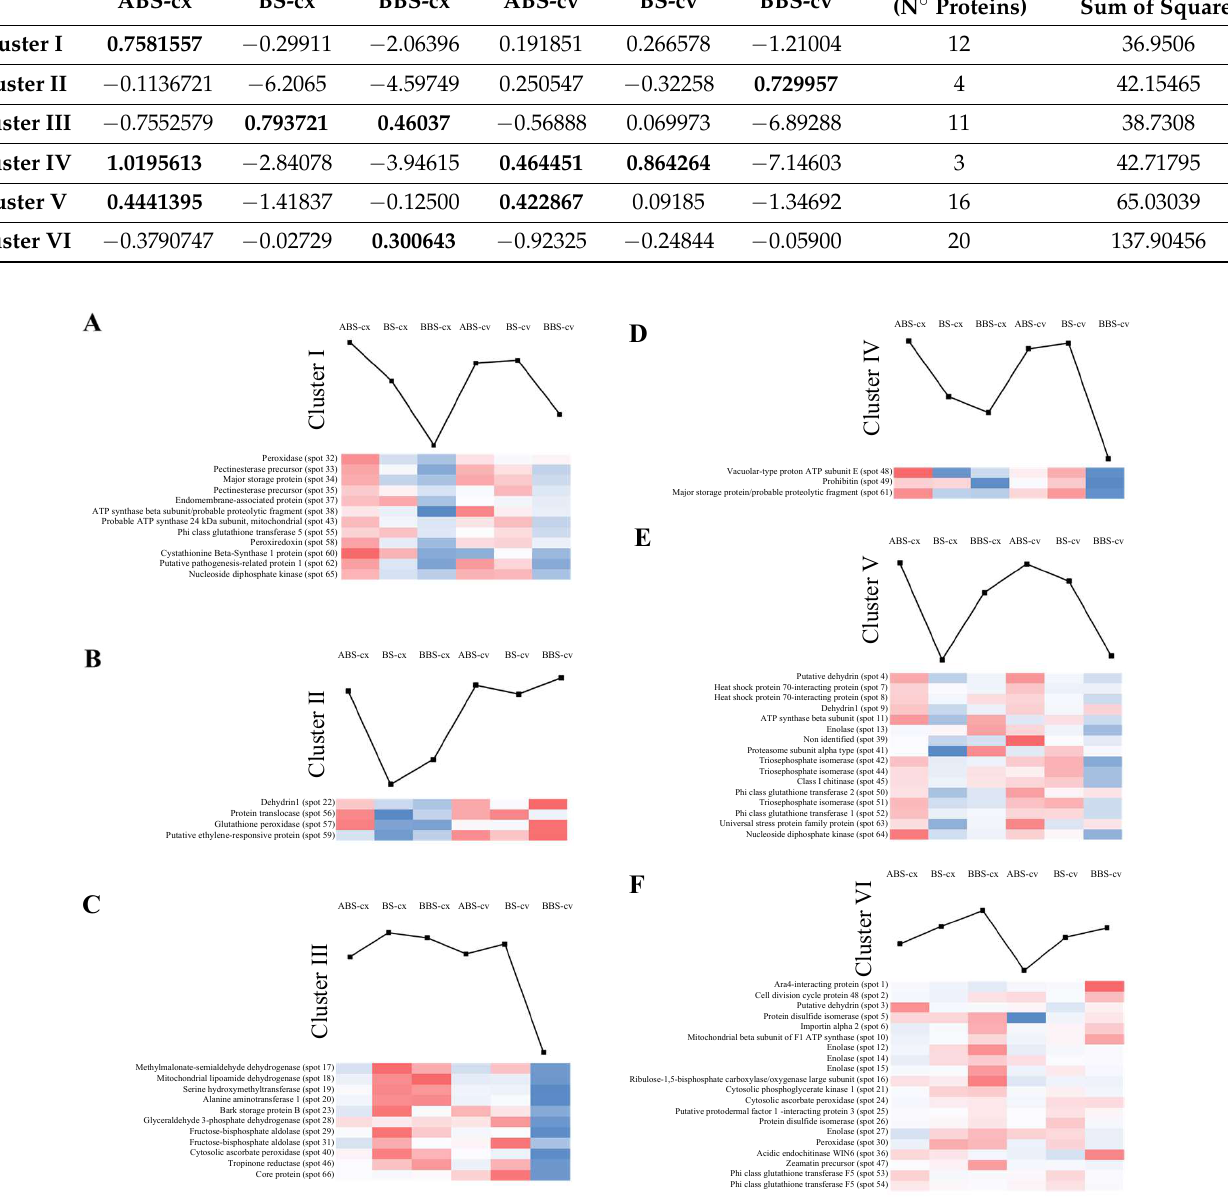
Withinss (Within Cluster Size Sum of Square)ABS-cx BS-cx BBS-cx ABS-cv BS-cv BBS-cv (N ◦ Proteins)